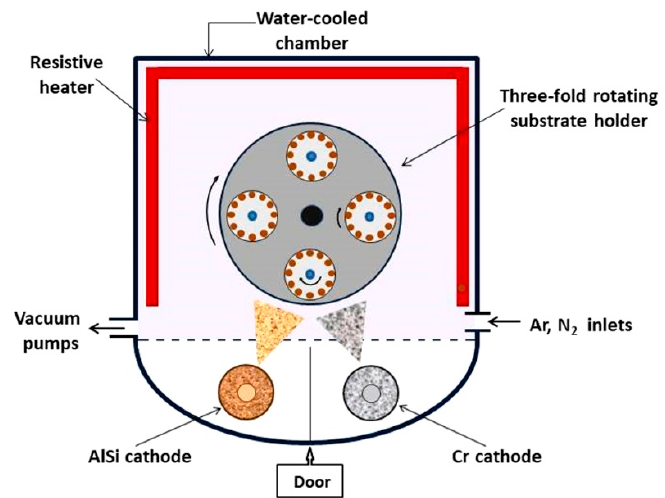
Figure 1. A scheme of the coating deposition in the chamber of the machine Platit π 80 + .